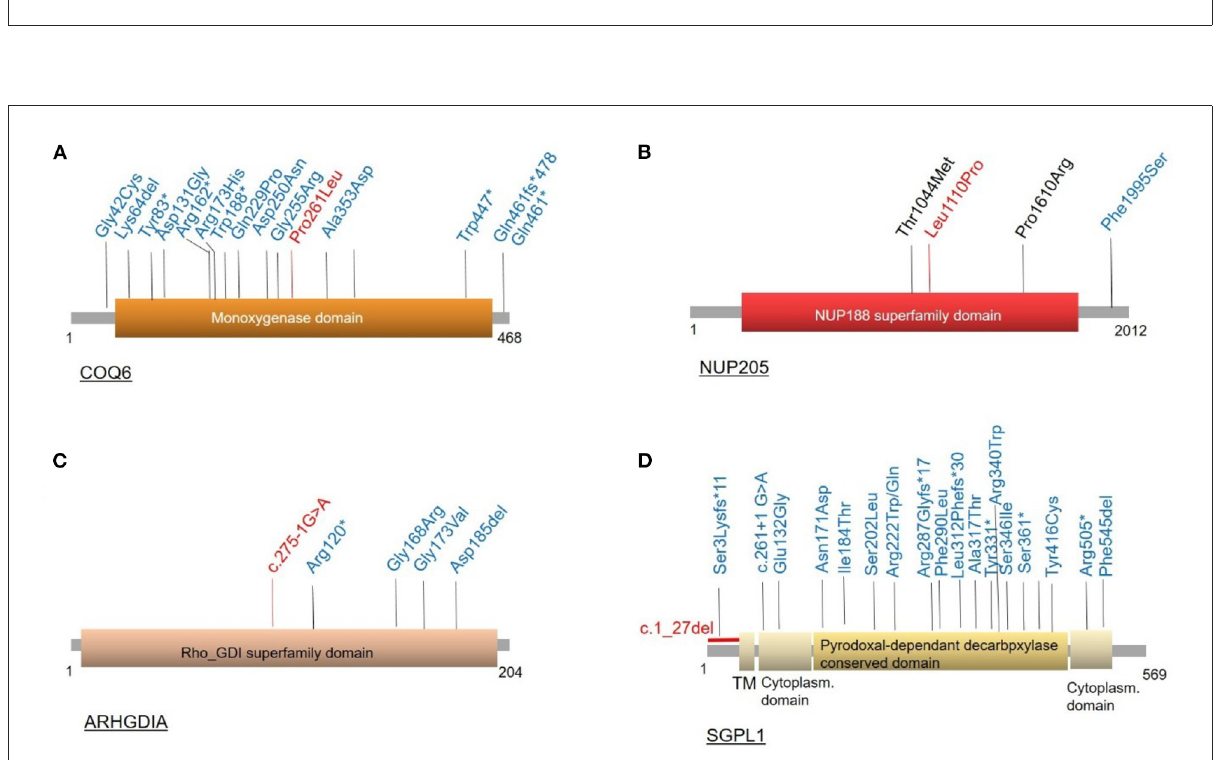
FIGURE2 Location of disease-causing variants in COQ6, NUP205 , ARHGDIA, and SGPL1 on protein level. (A) COQ6, (B) NUP205, (C) ARHDIA, and (D) SGPL1 variants. Previously reported variants are shown in blue, variants first reported in this publication marked in red.